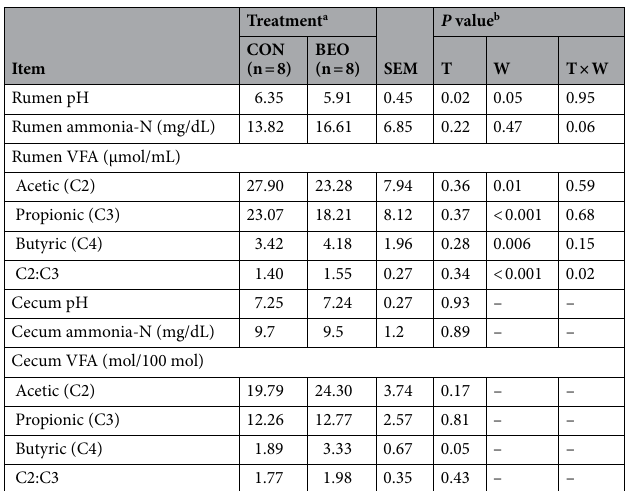
Table 2. Rumen and cecum mean values of pH, ammonia nitrogen (Ammonia-N), and volatile fatty acids (VFA) of control bull calves (CON) and bull calves supplemented with essential oils blend (BEO) in milk replacer from 4 to 60 days of age. a CON = control; BEO = 1 g/calf/day blend of essential oil. b T = treatment effect; W = week effect; T × W = treatment by week interactions.